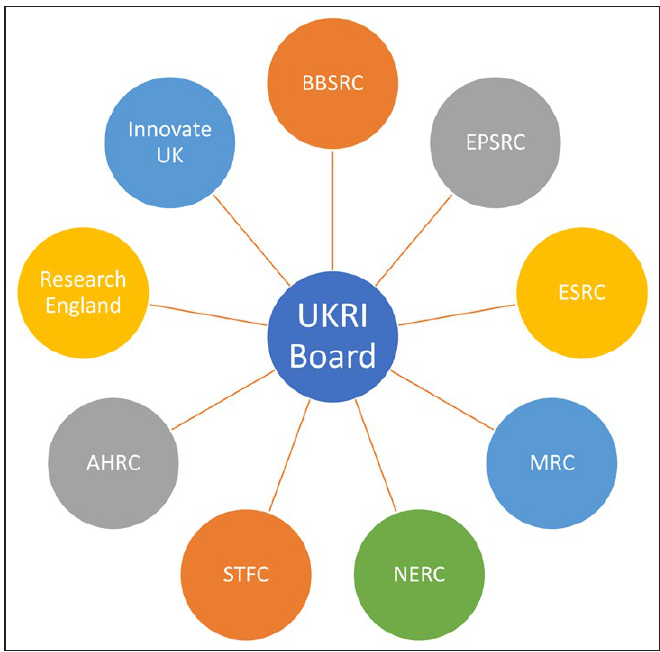
Figure 1: Under the Higher Education and Research Act 2017, the new UK Research and Innovation (UKRI) landscape is such that all seven Research Councils become committees of UKRI instead of statutory bodies in their own right. Illustration produced by Rodney